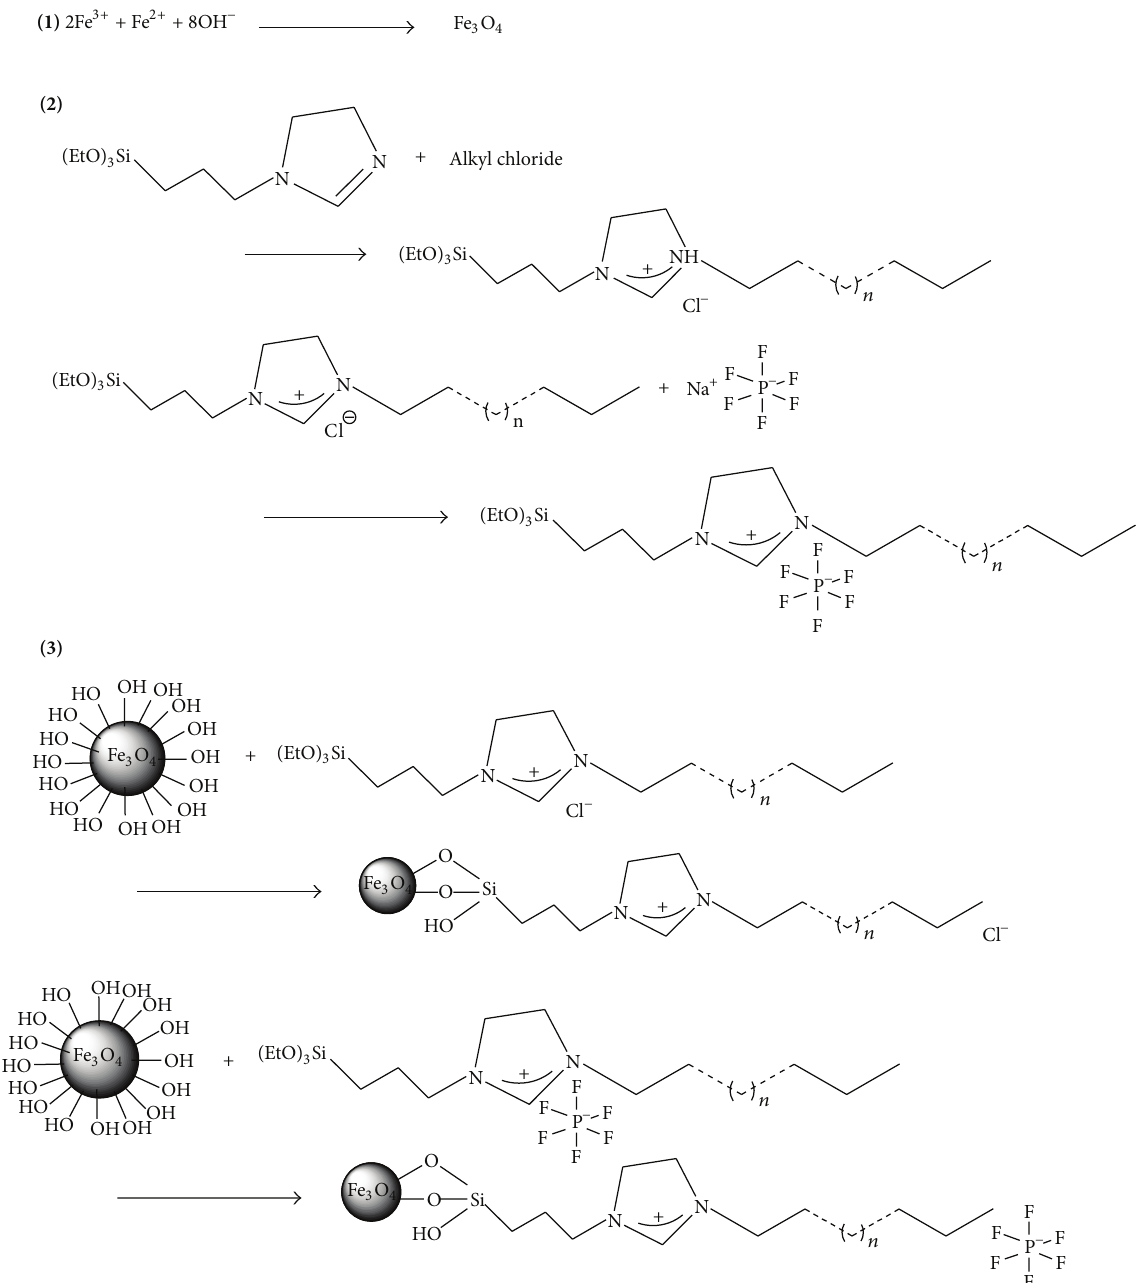
Scheme 1: Synthesis of ionic liquid-modified MNPs (alkyl=hexyl, octyl, and